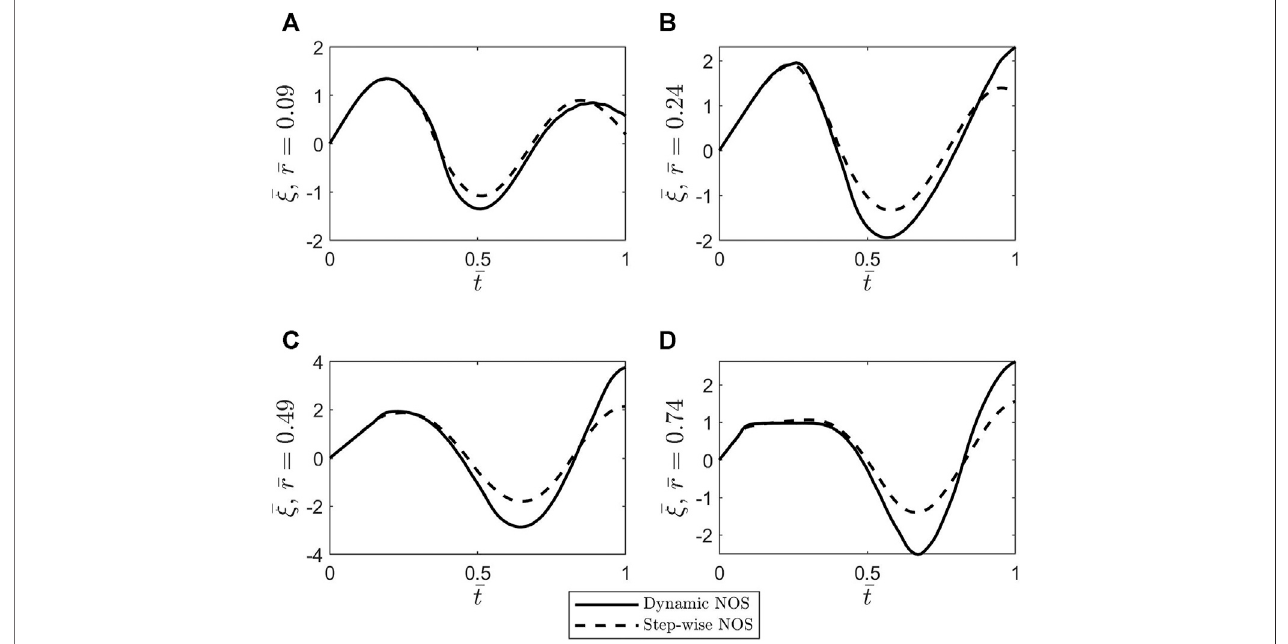
FIGURE 7 | Plots of the dimensionless axial displacement (cid:2) ξ versus the dimensionless time (cid:2) t at various dimensionless radial locations (cid:2) r within the vascular wall (A) r ― (cid:2) 0.09, (B) r ― (cid:2) 0.24, (C) r ― (cid:2) 0.49, and (D) r ― (cid:2) 0.74 for the variable fractional order α ( t ) corresponding to the case of dynamic NOS (solid line) and to the case of stepwise NOS (dashed line).